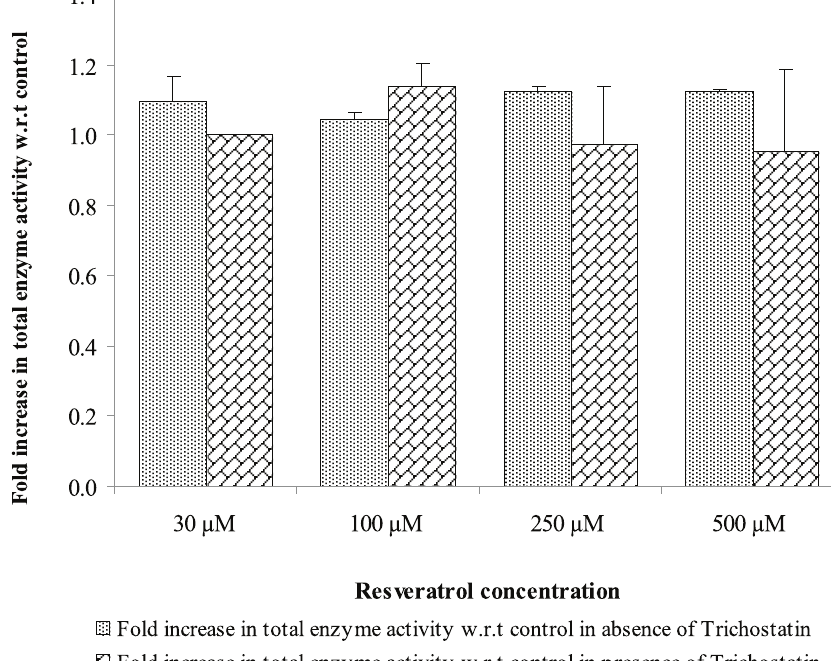
Figure 5. SIRTI activation following incubation of Resveratrol with rHos2. Fold activation of the Sirt1 like activity following incubation of recombinant Hos2 enzyme with different concentration of resveratrol in presence and absence of HDAC inhibitor trichostatin. Assays were carried out in triplicates and analysed for statistical significance by one way ANOVA (Bonferroni’s Multiple Comparison Test) using GraphPad Prism